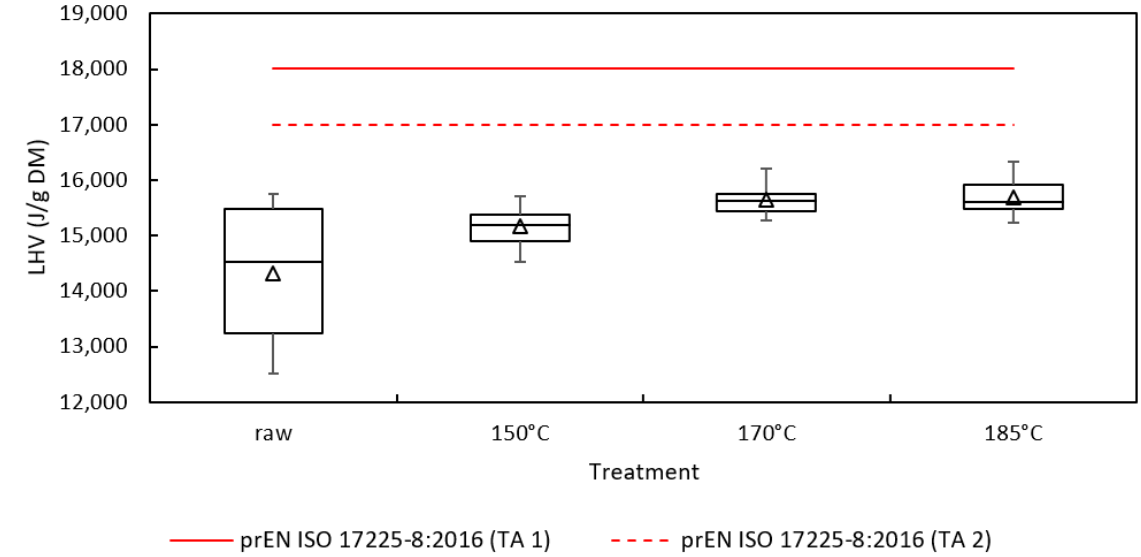
Figure 2. Lower heating values (LHV) based on dry matter (DM) for raw and hydrothermally treated (biochars) organic fraction of municipal solid waste (OFMSW) as boxplots including mean values ( Δ ). Minimum requirements for fuels according to prEN ISO 17225-8:2016 [46] category 1 and 2 are also presented.